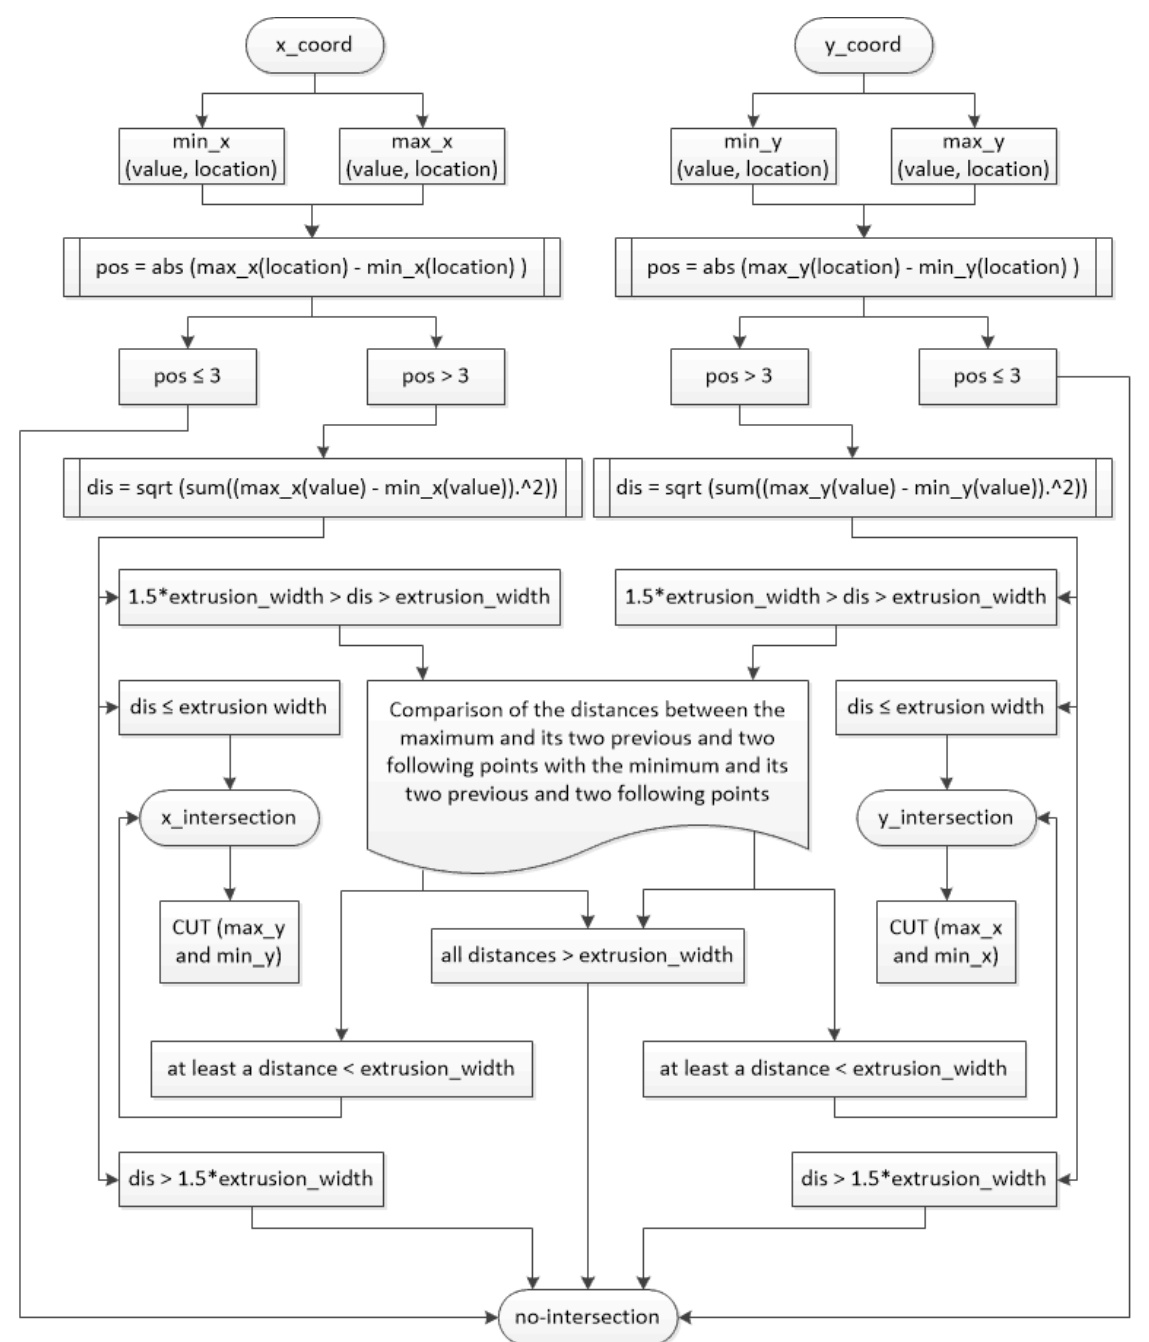
Figure 7. Modelling by sections diagram.